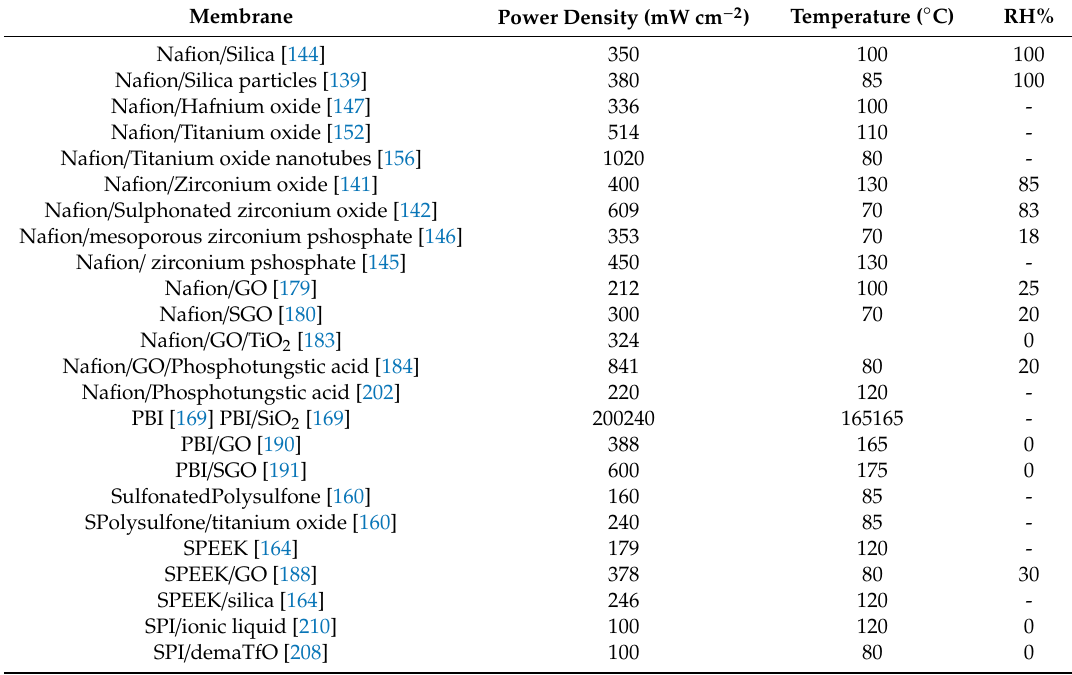
Table 3. Summary of hydrogen PEMFC best performance using composite